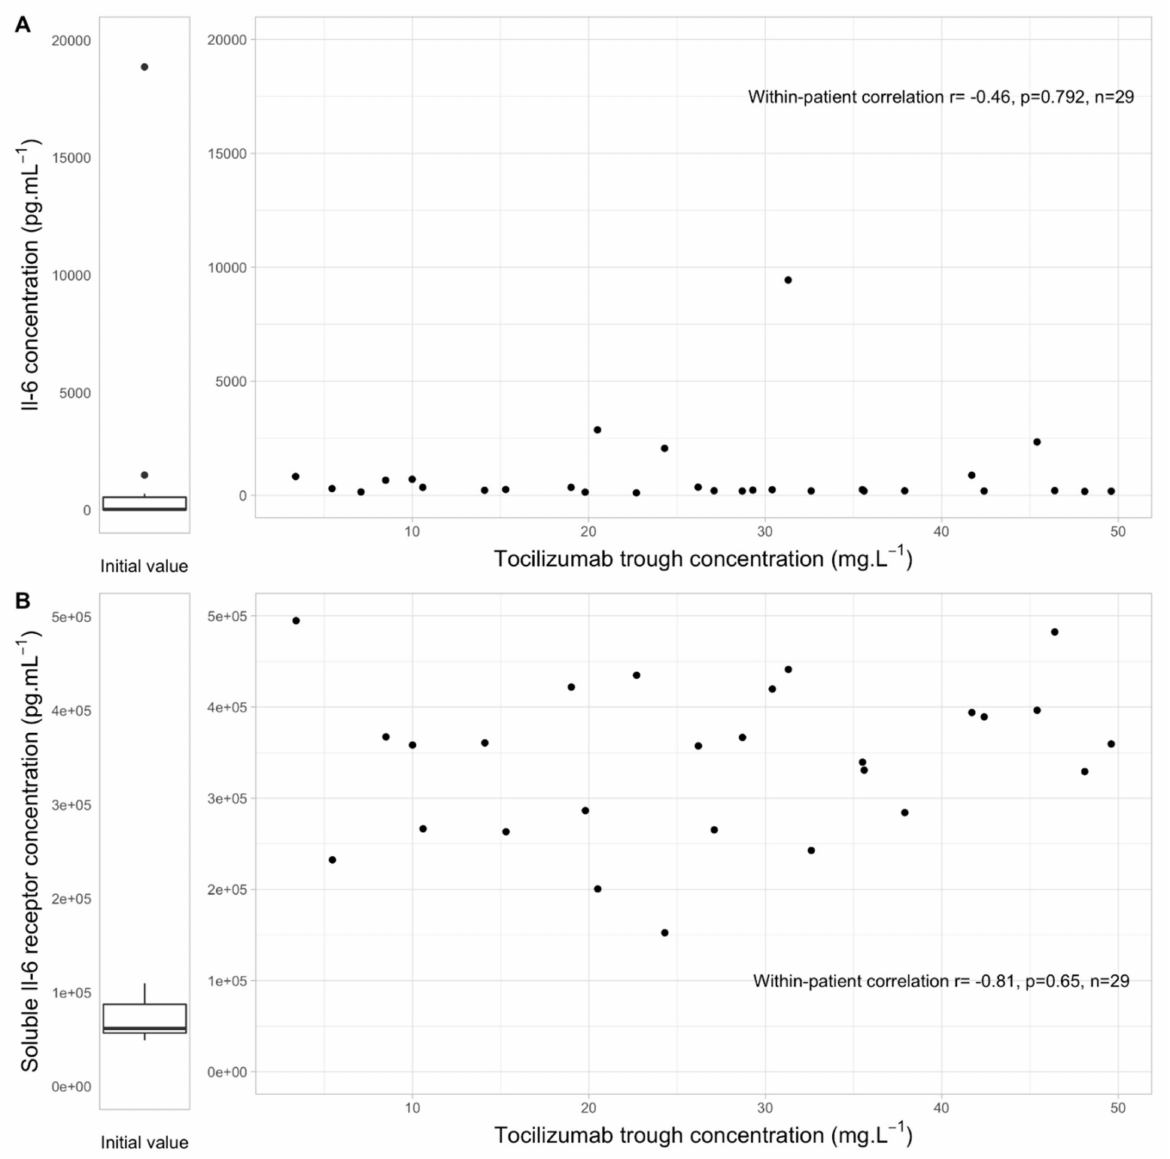
Figure 2. Within-patient correlation between tocilizumab trough concentration and IL-6 ( A ) or soluble IL-6 receptor ( B ) ( n = 29), with initial IL-6 and soluble IL-6 receptor concentration before tocilizumab